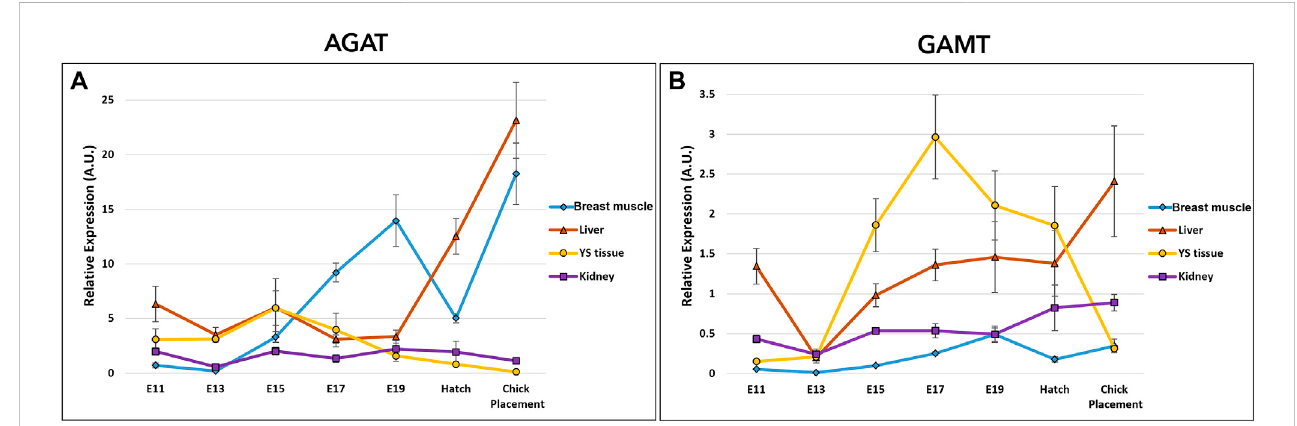
FIGURE 4 Dynamic expression of genes involved in creatine synthesis (A) Arginine-glycine amidinotransferase (AGAT), catalyzes the reaction between glycine and arginine to create GAA (B) Guanidinoacetate N-methyltransferase (GAMT), responsible for the methylation of GAA to create creatine. Expression analysis of AGAT and GAMT by a two-way ANOVA followed by Tukey ’ s HSD test revealed signi fi cant interactions between the effects of age and tissue. ( p < 0.05), n = 6 per day.